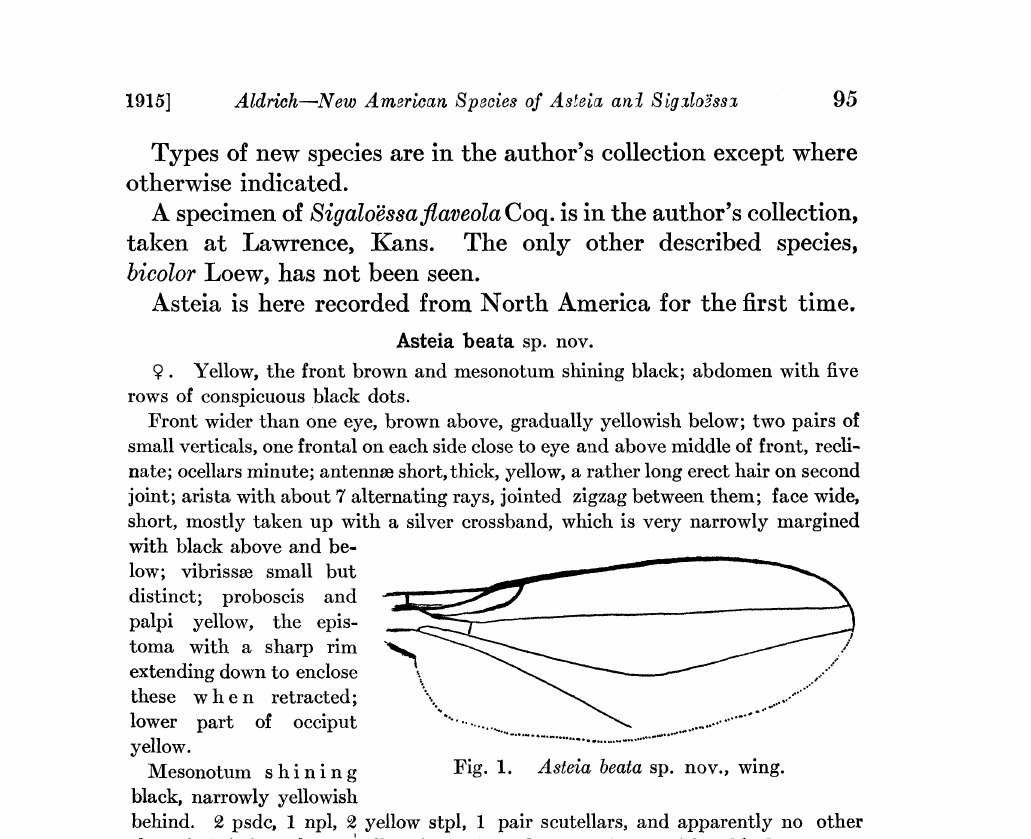
Fig. 1. Asteia beata sp. nov.,